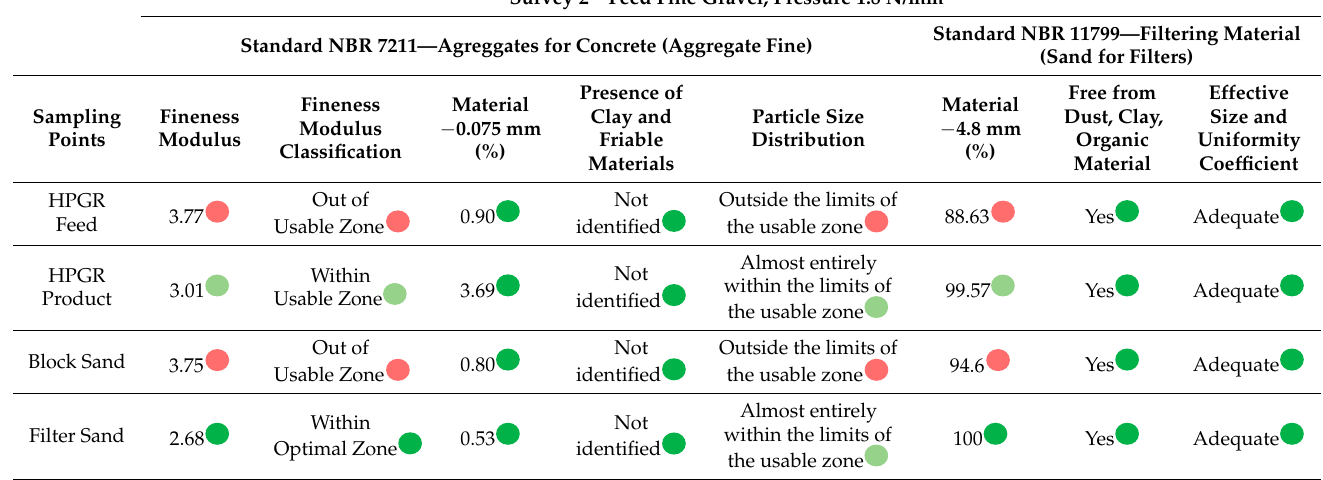
Table 8. Survey 1 product analysis.